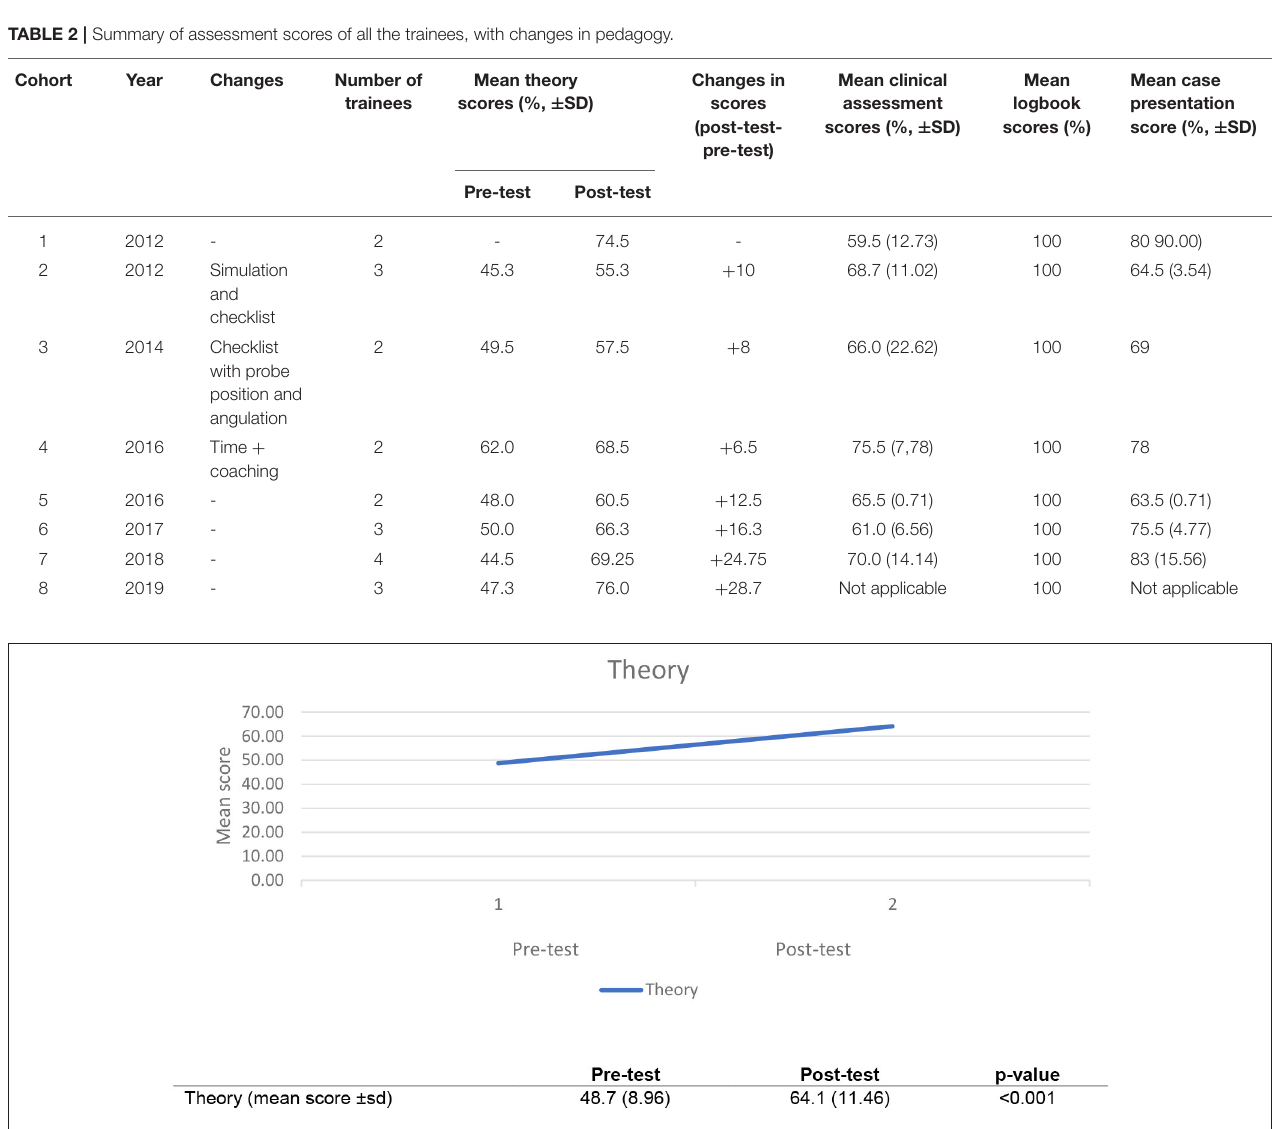
FIGURE 5 | Chart showing improvement in post-tests mean scores across